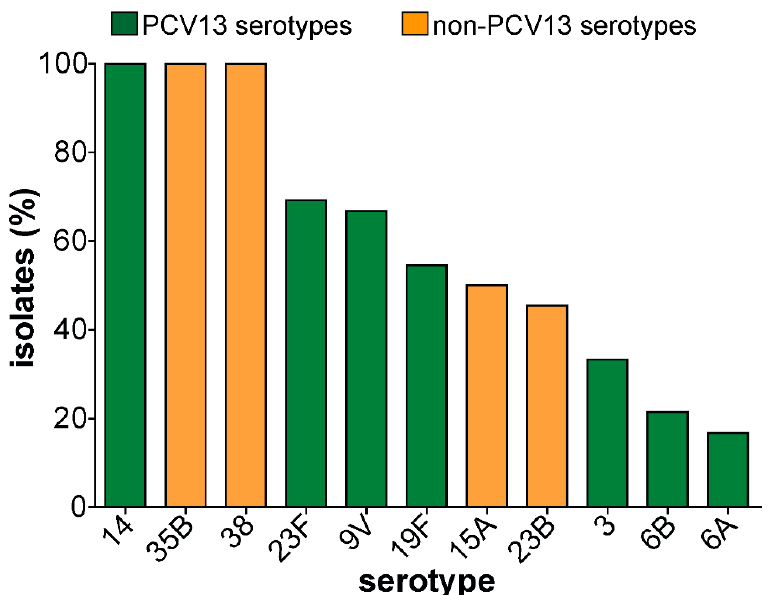
Figure 3. Penicillin susceptibility by serotype among pneumococcal strains. Serotypes were grouped into penicillin resistant pneumococci (PenRP) in red color and penicillin susceptible pneumococci (PenSP) in grey color. * PCV13 serotypes.